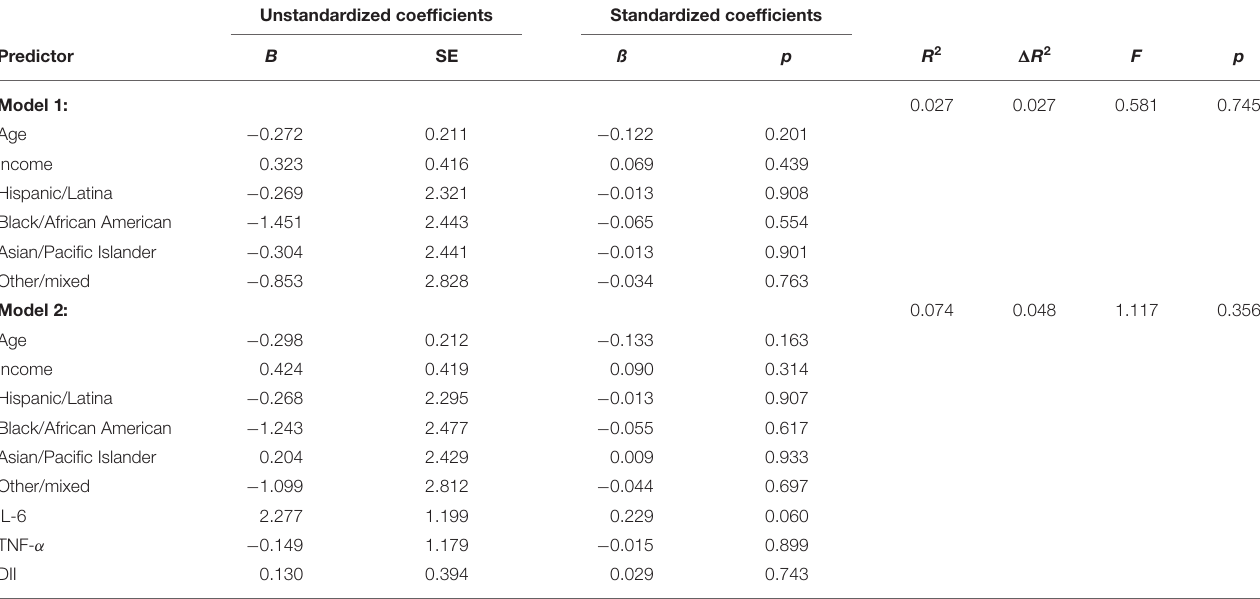
TABLE 6 | Summary of multiple regression analysis examining the adjusted relationship between inflammation variables and total BDI-II scores. Unstandardized